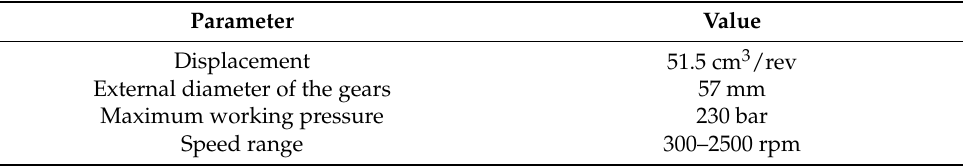
Figure 1. ( a ) Photo of the Casappa Magnum HDP type pump; ( b ) view of the thrust plate type A with the peripheral channels. Table 1. Main parameters of the pump under Table 1. Main parameters of the pump under study.